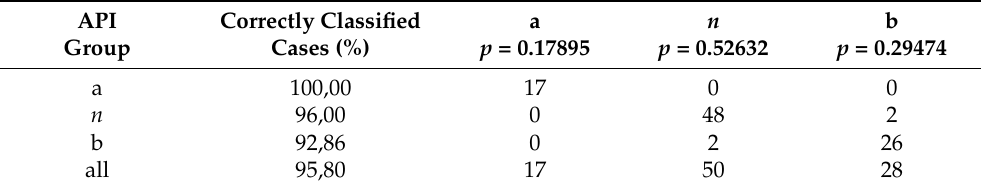
Table 2. Classification matrix for the model using discriminant variables: PhCharge, B2, pKa, M/P, log k HSA , log k IAM , NP, eL, log U/D. API Correctly Classified a p = Group Cases (%)